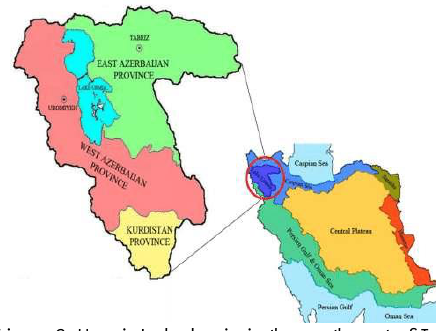
Figure 2. Urmia Lake basin in the northwest of Iran (Safaee et al.,